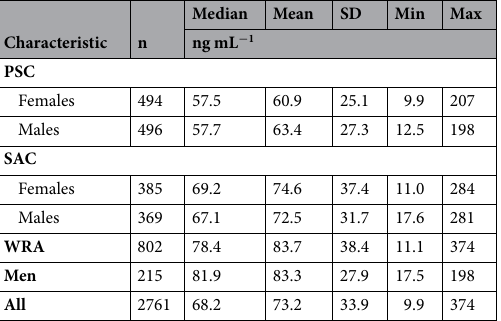
Table 1. Plasma selenium (Se) concentration among demographic groups in Malawi. n = sample number in cohort; SD = standard deviation; Min = minimum value in the cohort; Max = maximum value in the cohort; PSC = preschool children; SAC = school-aged children; WRA = women of reproductive age (aged 15–49 years); Men (aged 20–54 years).